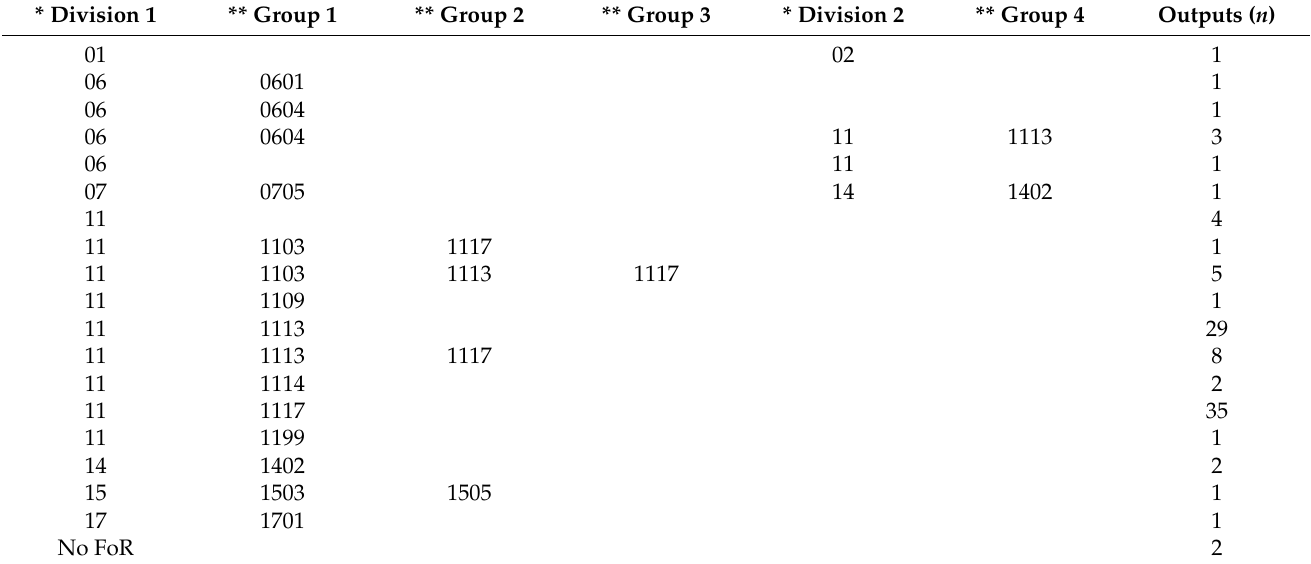
Table 5. Field of Research of journals publishing the top-100 AAS outputs about